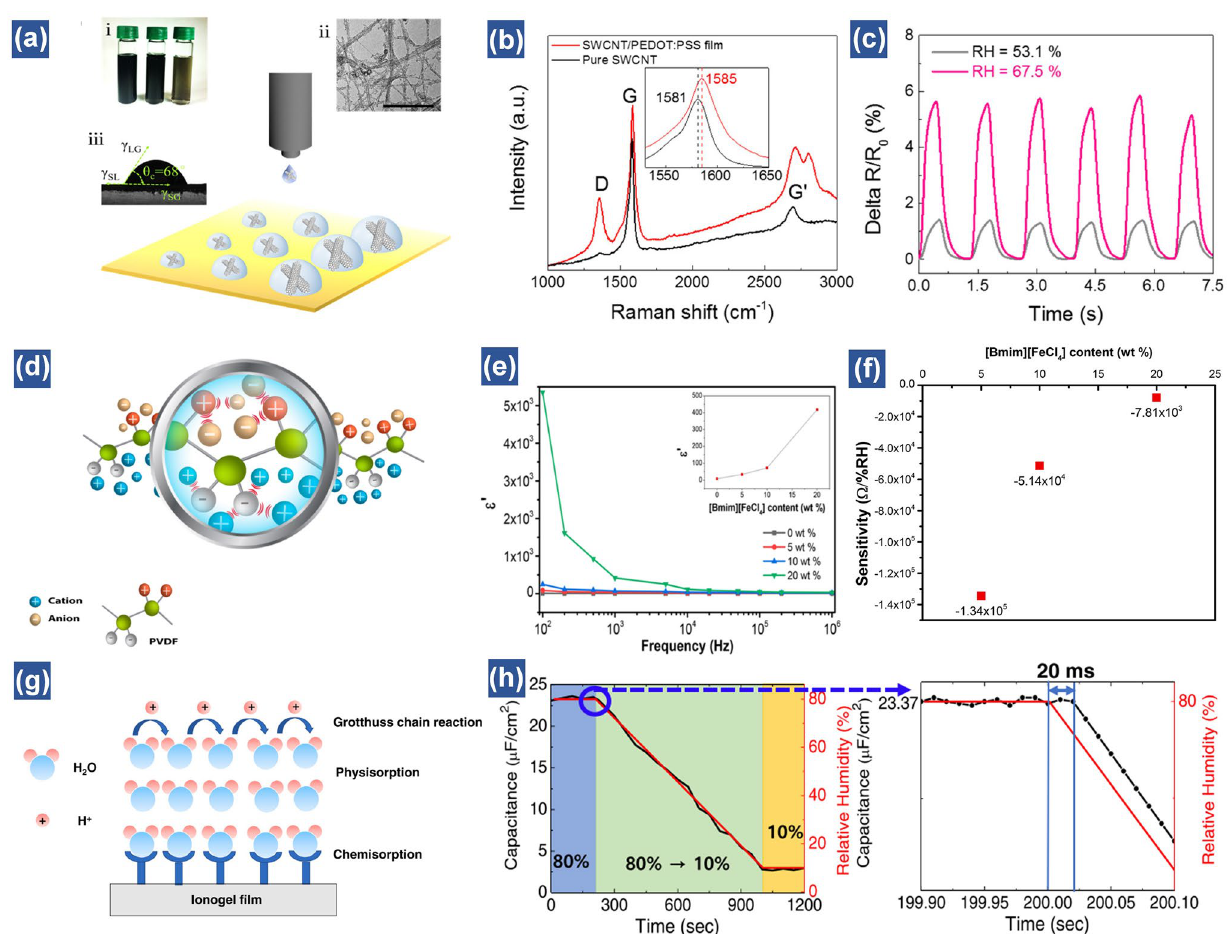
Fig. 6 Synthetic conductive polymers-based flexible humidity sensors. ( a ) Schematic illustration of the preparation of SWCNT/PEDOT:PSS hybrid films through CRL. Insets are SWCNT/PEDOT:PSS hybrid inks with different concentrations (0.1, 0.2, and 0.3 mg mL −1 , from right to left) (i), and their TEM image (ii), and contact angle on PET substrate (iii); scale bar is 50 nm. ( b ) Raman spectra; inset shows the shift G peak. ( c ) Short cyclic tests of humidity-resistance response with different RH value or distance [141]. Copyright 2015 ACS Publications. ( d ) Ion − dipole interactions between PVDF and [Bmim][FeCl 4 ]. ( e ) PVDF/IL composites electrical response of dielectric constant ( f ) Sensor sensi- tivity as a function of the [Bmim][FeCl 4 ] content [143]. Copyright 2019 ACS Publications. ( g ) Schematic of the humidity sensing mechanism of the PIL. ( h ) Capacitance as a function of the measuring time with respect to the increase in RH from 10 to 80% [147]. Copyright 2021